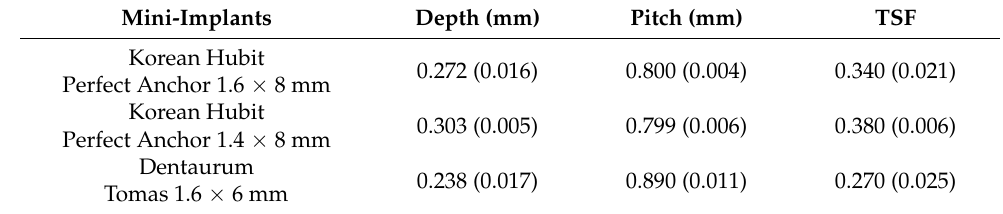
Table 5. Depth, pitch and TSF average values and standard deviations by type of mini-implant. Mini-Implants